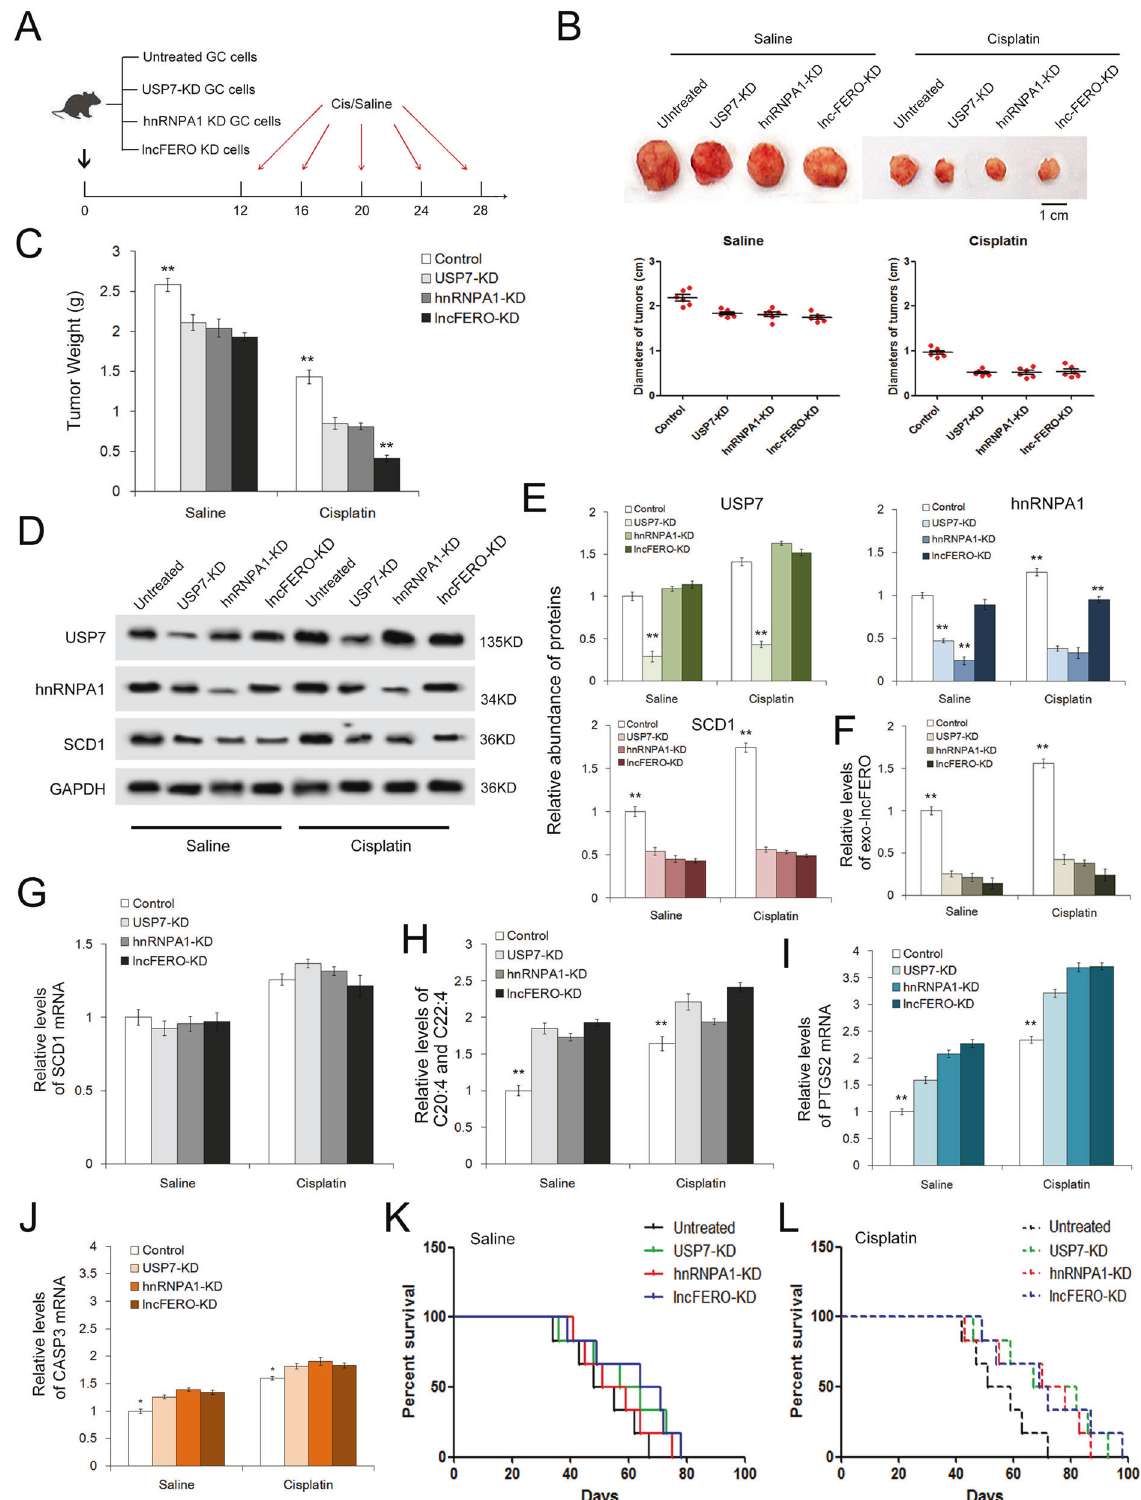
Fig. 8 In vivo role of the USP7/hnRNPA1/lncFERO pathway in regulating ferroptosis and chemosensitivity of gastric tumors. A Schematic description of the experimental design used to establish the animal model. B Images and the diameters of tumors in each group ( n = 6). C Weight measurements of the tumors described above ( n = 6). D WB analysis of USP7, hnRNPA1 and SCD1 in tumor tissues ( n = 3). E Quantitative analysis of ( D ) ( n = 3). F Relative levels of serum exo-lncFERO in each group ( n = 6). G Relative levels of SCD1 mRNA in tumor tissues ( n = 6). H Relative levels of PUFAs in tumor tissues ( n = 6). I , J Quanti fi cation of a ferroptosis marker ( I ) and an apoptosis marker ( J ) in each group ( n = 6). K , L Kaplan – Meier curves of mice in the saline-treated groups ( K ) and cisplatin-treated groups ( L ) ( n = 6). ** p < 0.01.